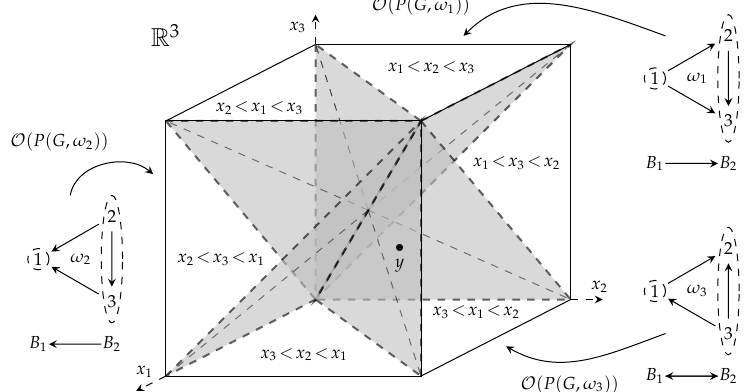
Figure 2. The hyperplane arrangement A ( G ) for G = K 3 . Three orientations in Acyc ( G ) are shown, along with the corresponding chambers of A ( G ) , and the preposet that results when contracting P i = P ( G , ω i ) by the partition π = { B 1 = { 1 } , B 2 = { 2,3 }} of V . The intersection of each (closed) chamber c ( P i ) with [ 0,1 ] 3 is the order polytope O ( P i ) of P i . The point y is supposed to lie on the hyperplane x 1 = x 2